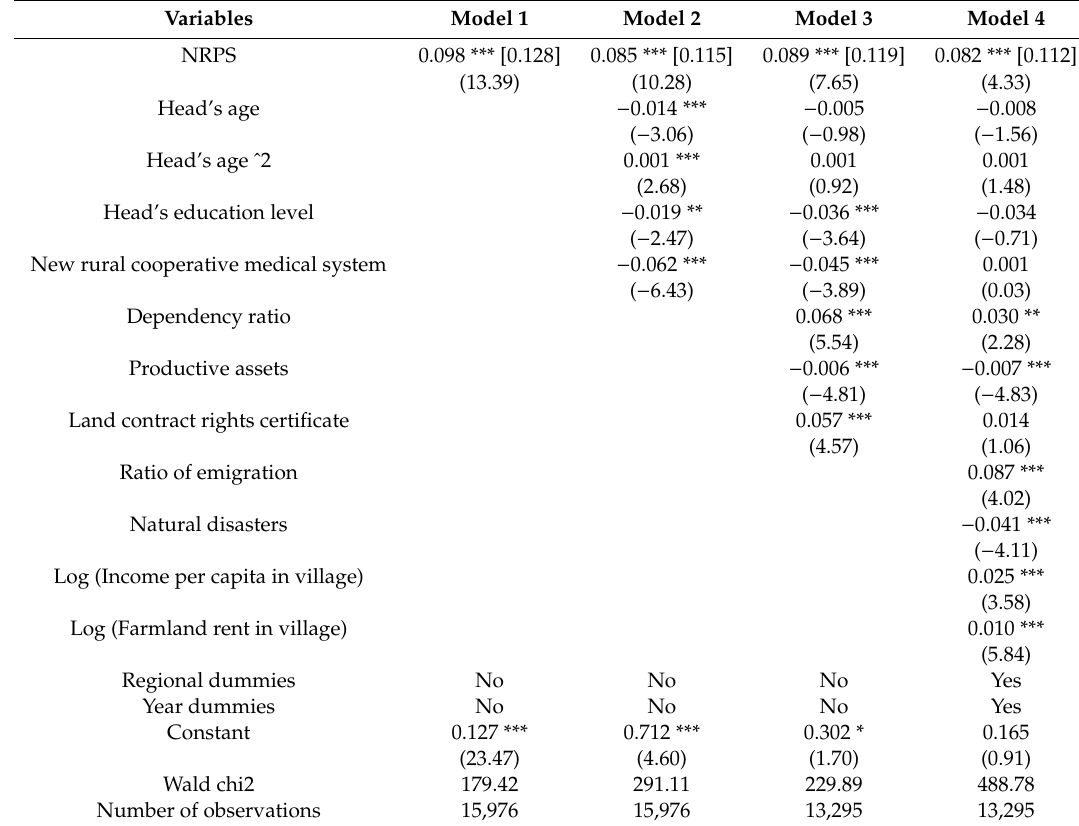
Table 6. The impact of the NRPS on the scale of farmland area transferred